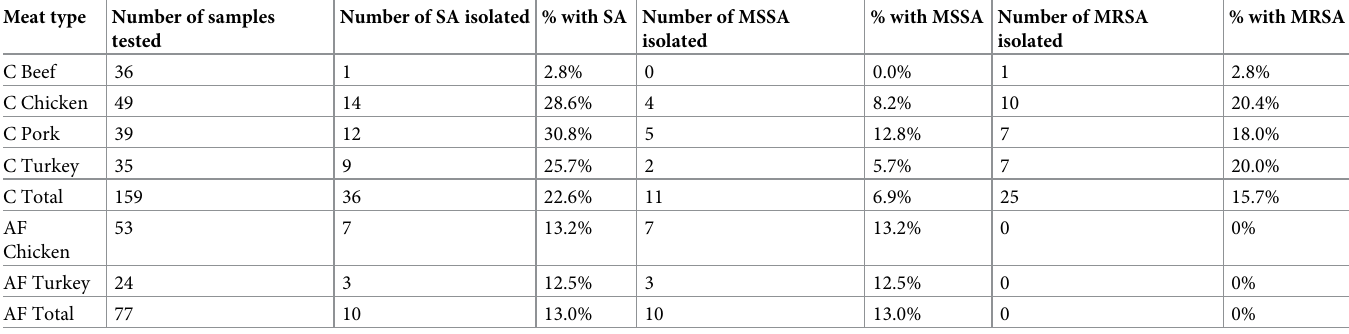
Table 3. Prevalence of Staphylococcus aureus in raw meat